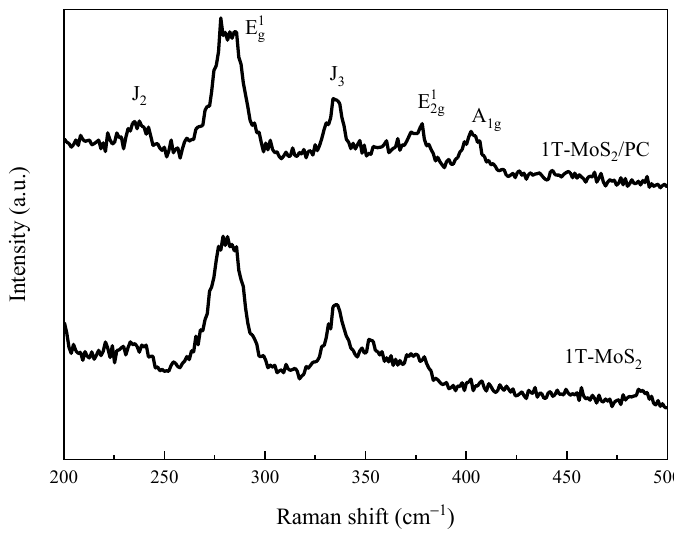
Figure 5. Raman spectra of 1T-MoS 2 /PC and 1T-MoS 2 .